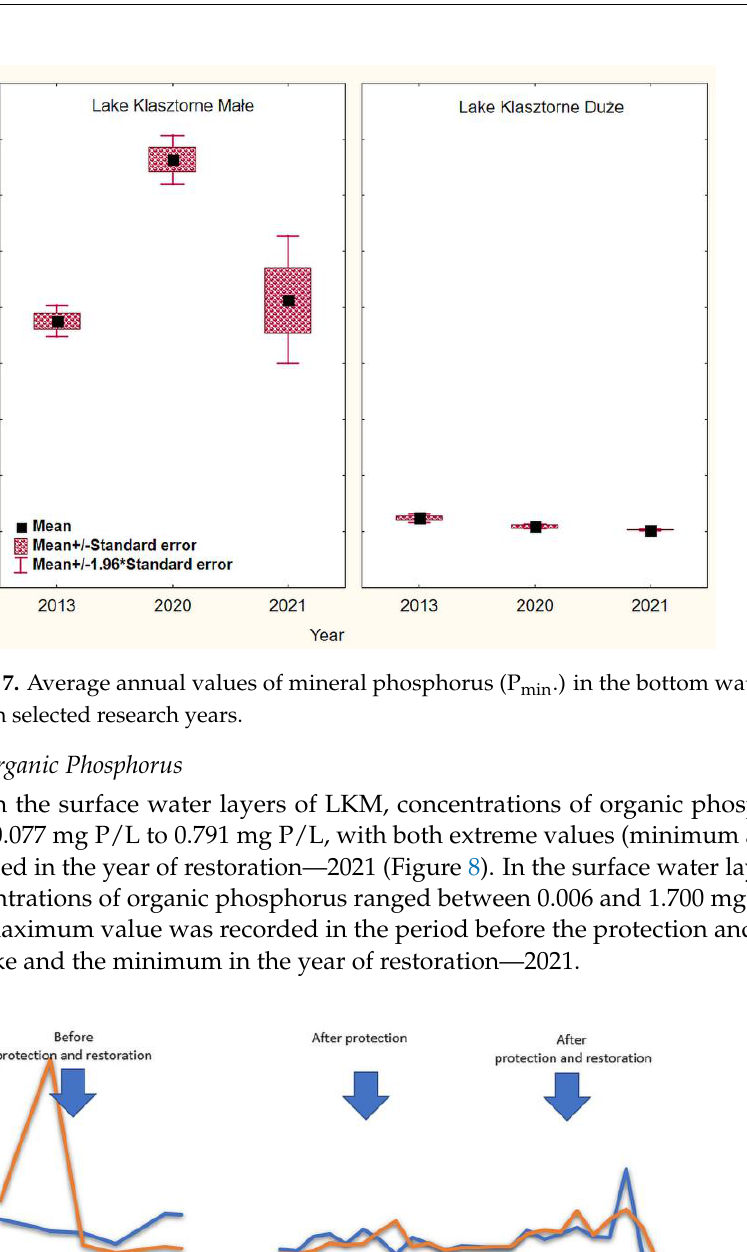
Figure 9. Average annual values of organic phosphorus (P org .) in the surface water of Klasztorne lakes in selected research years. The bottom water layers of LKM were very rich in organic phosphorus, the concen- tration of which varied from 0.350 mg P/L to 12.200 mg P/L. Both extreme results were recorded in 2013, before protection and restoration measures were implemented (Figure 10a,b). In the eutrophic LKD, the range of organic phosphorus concentrations was not as wide as in the meromictic water body (LKM) and was between 0.005 mg P/L (2021-after